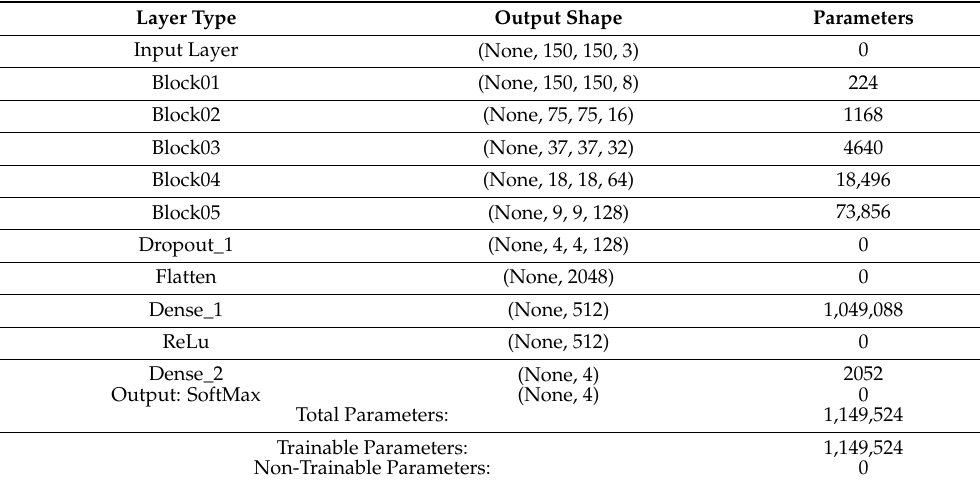
Table 4. The total number of parameters utilized in the proposed DSCC_Net